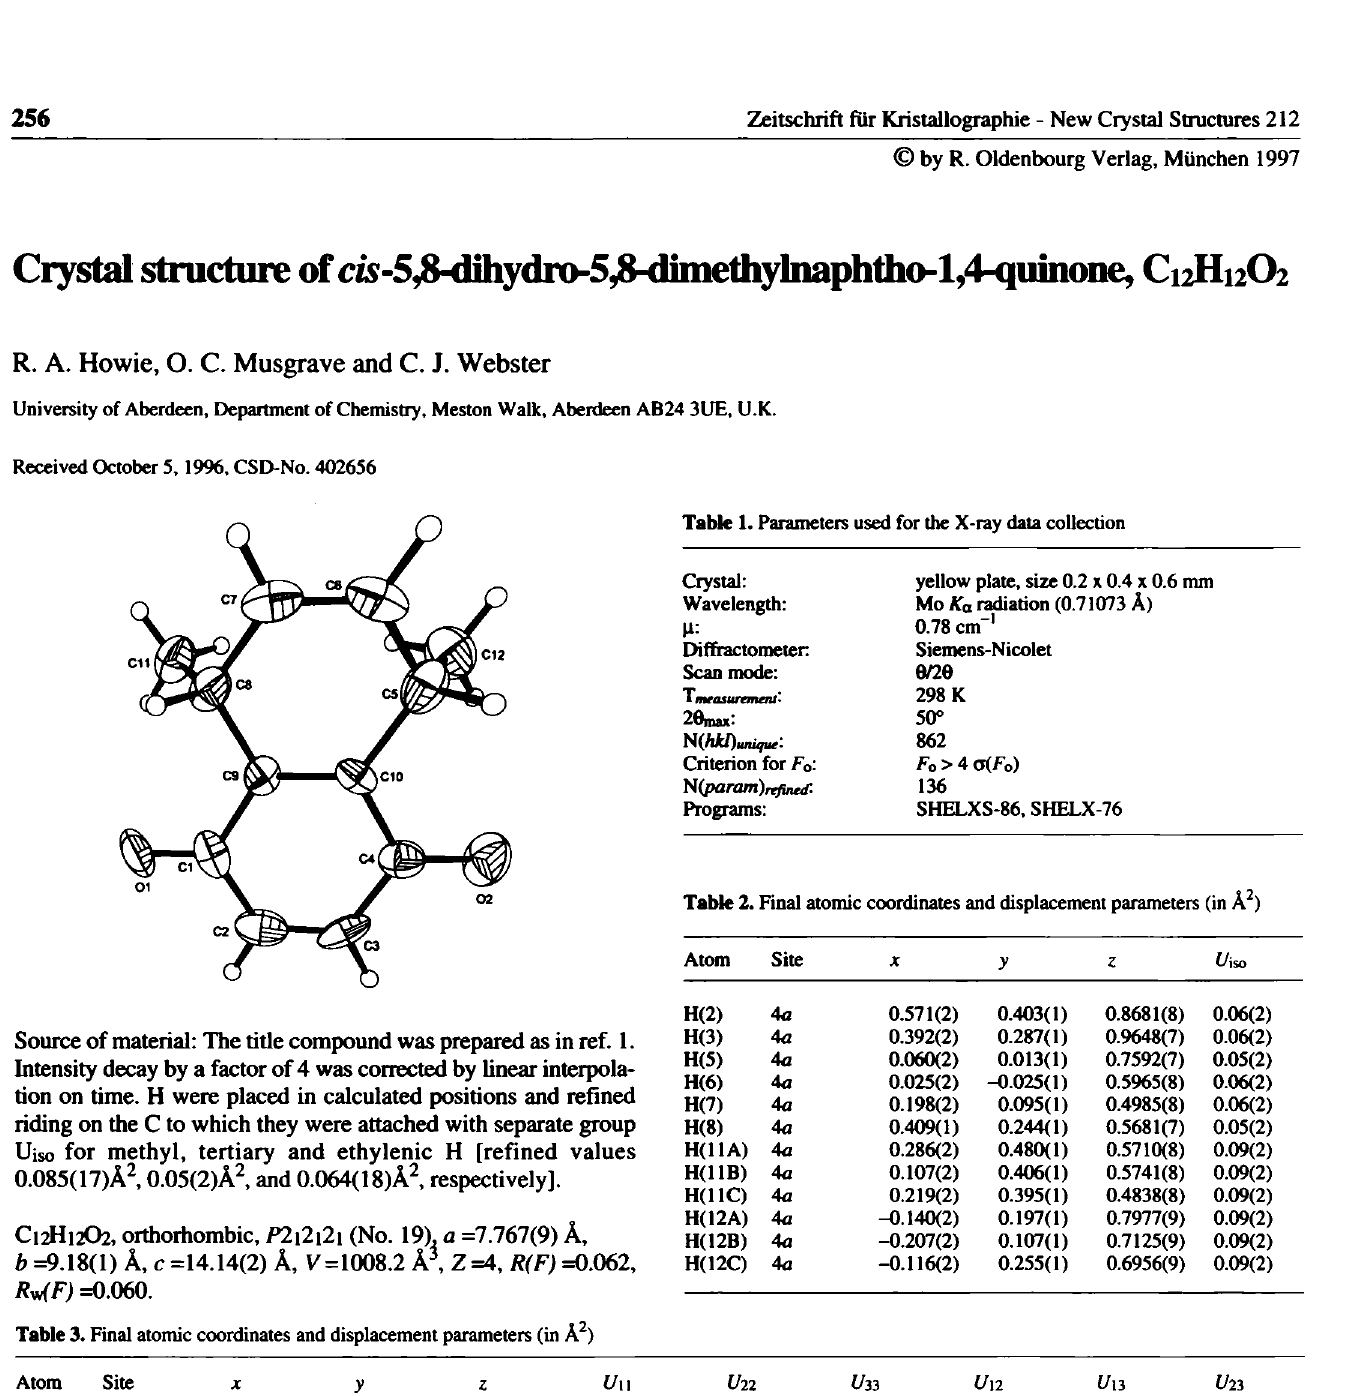
Table 3. Final atomic coordinates and displacement parameters (in À 2